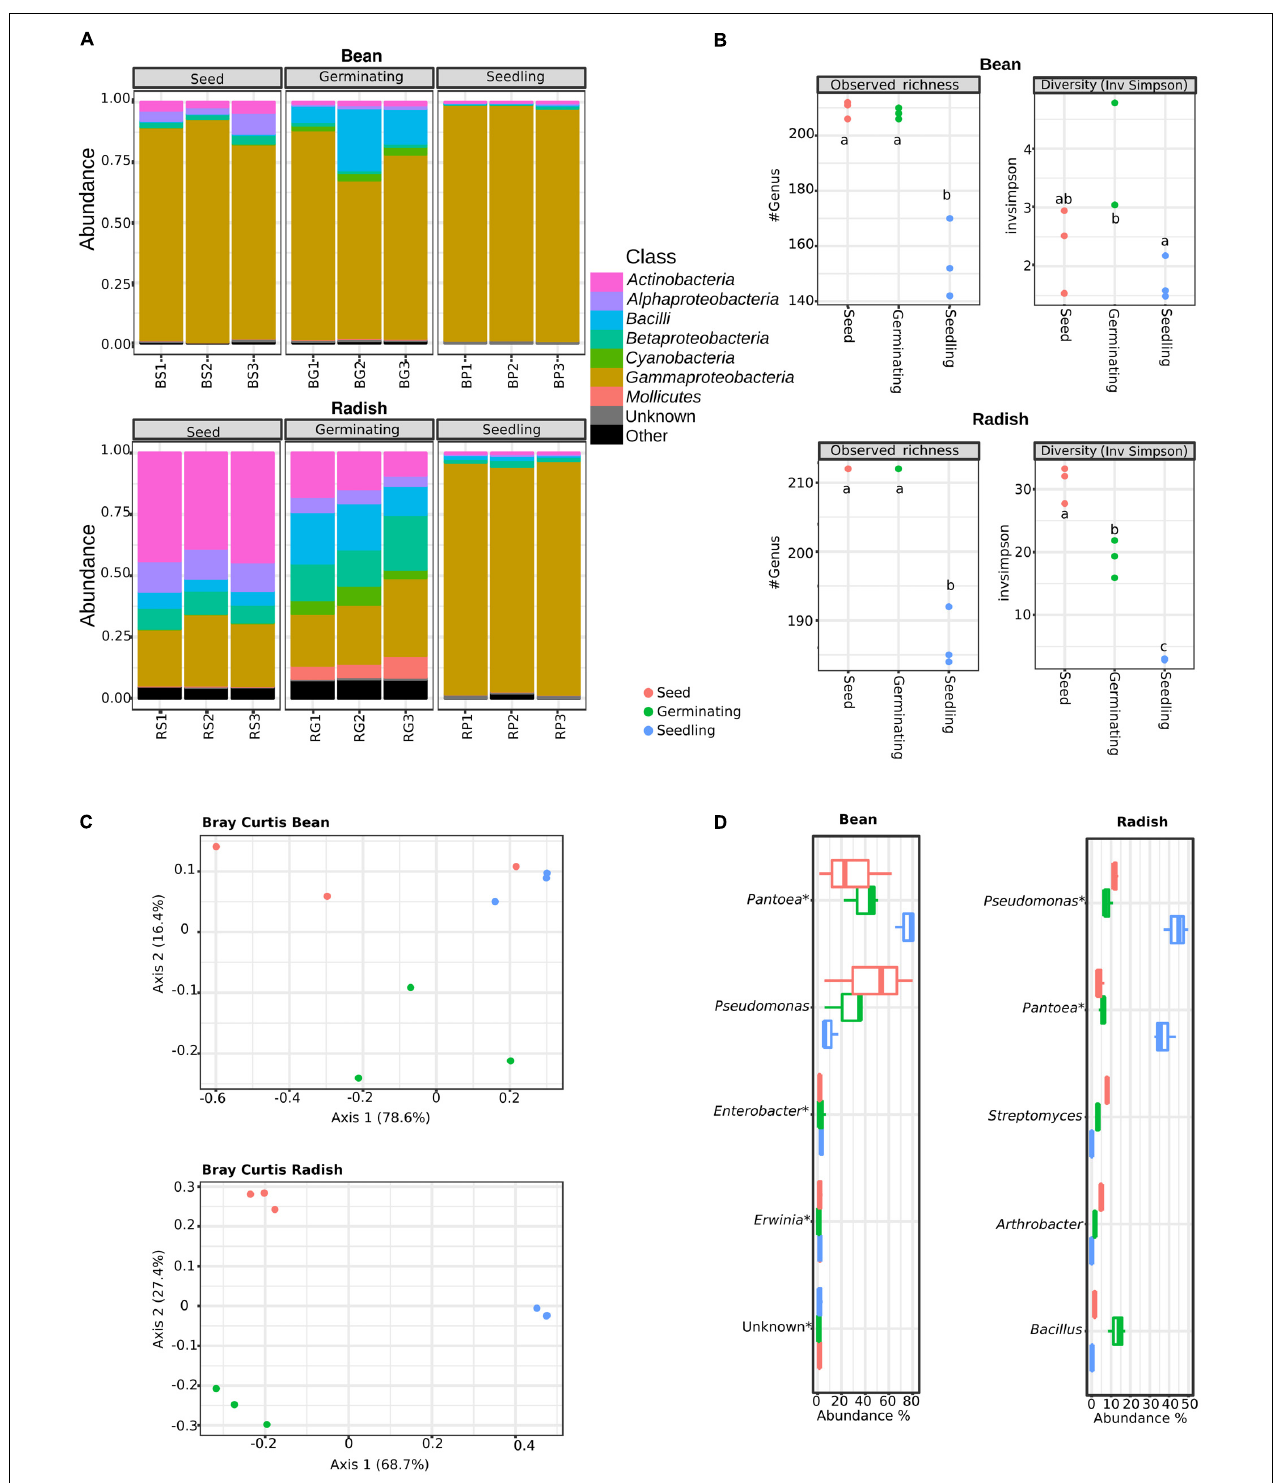
FIGURE 1 | Structure and composition of microbial assemblages associated to seeds, germinating seeds and seedlings. (A) Phylogenetic assignment of reads in bacterial classes was performed with Clark, a k-mer based approach. (B) Changes in microbial richness (left panels) and diversity (right panels) among the samples investigated. Letters indicate differences between individual means as assessed with one factor ANOVA with post hoc Tukey HSD ( P < 0.01). (C) PCoA plots based on Bray–Curtis index calculated at the genus level. (D) Abundant bacterial genus in the samples investigated. Asterisks ( ∗ ) indicate taxa that are significantly more abundant in seedling samples in comparison to seeds (DeSeq2; log2 FC > 3, P < 0.01). S, seeds; G, germinating seeds and P: Seedlings.